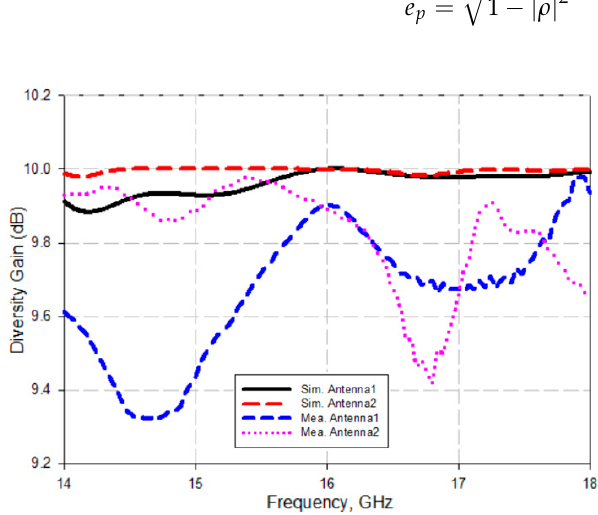
Figure 15. Measurement and simulation of the diversity gain (DG).